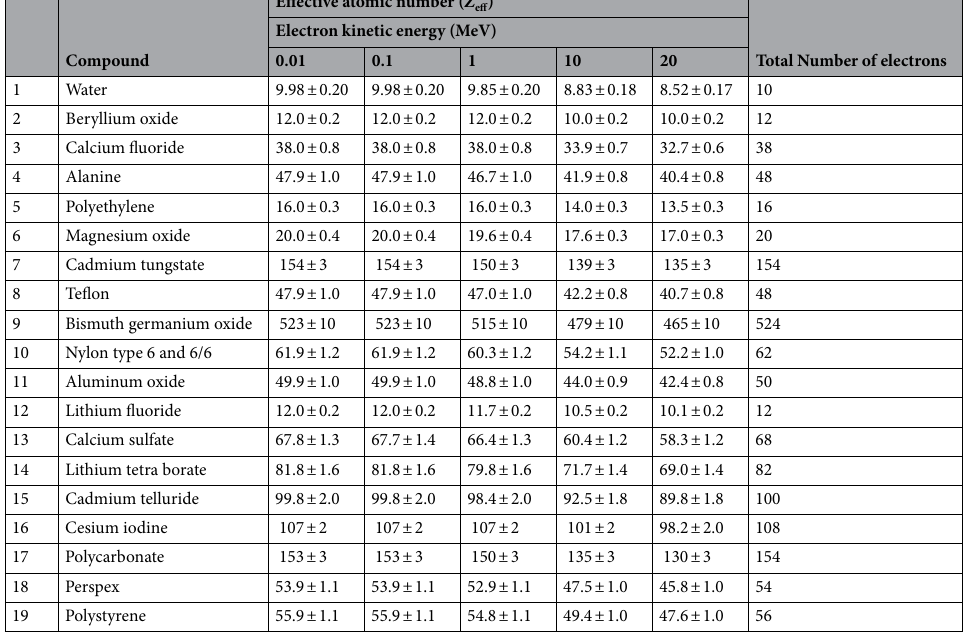
Table 3. Results of effective atomic number for different compounds in a few of the kinetic energy using collisional stopping power of electron. The uncertainties are due to the uncertainty of the stopping powers in the NIST data library.